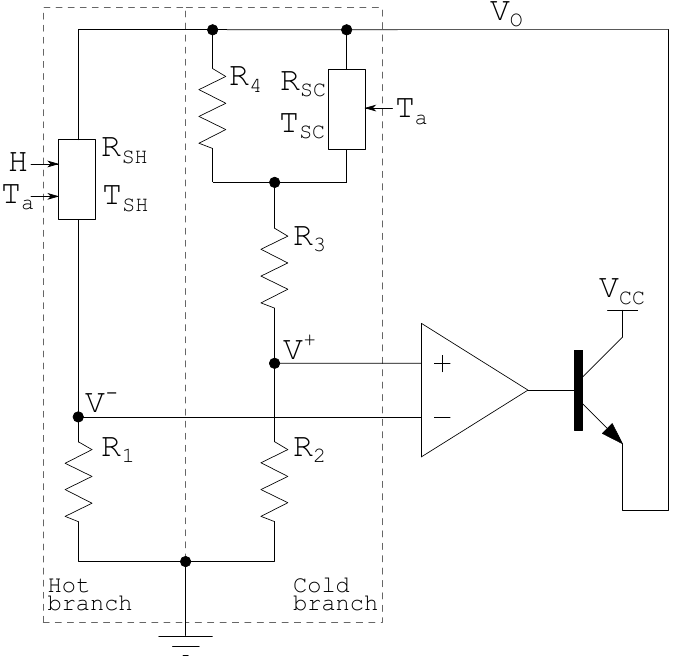
Figure 3. Proposed CTD Wheatstone bridge architecture